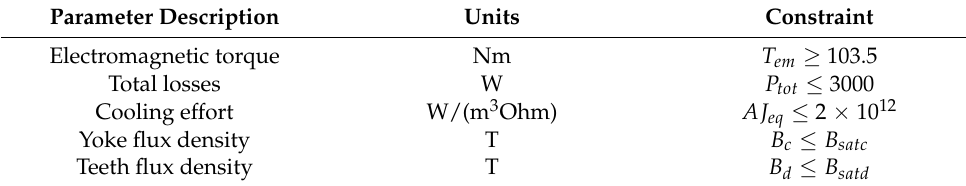
Table 8. Optimization constraints for Direct FEA.